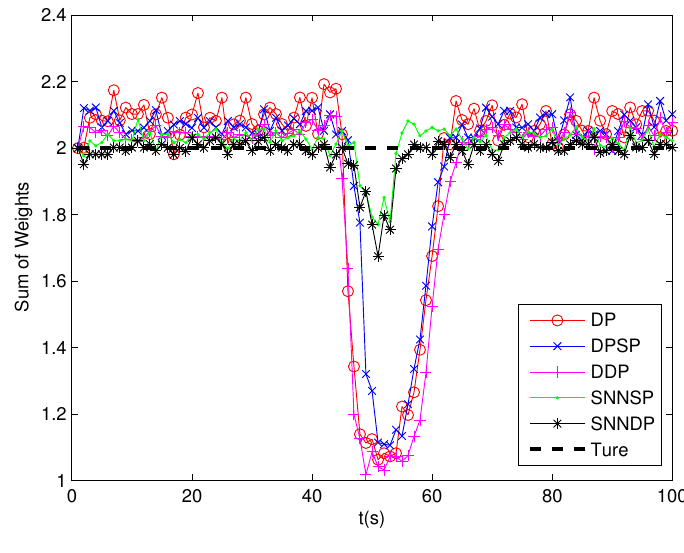
Figure 7. Sum of